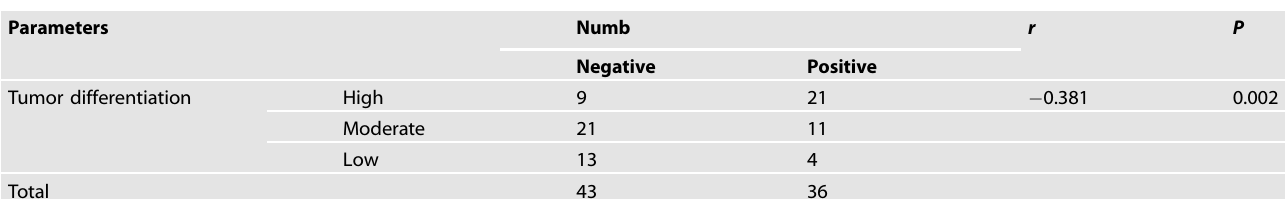
Table 1. The relationship between Numb and tumor differentiation.